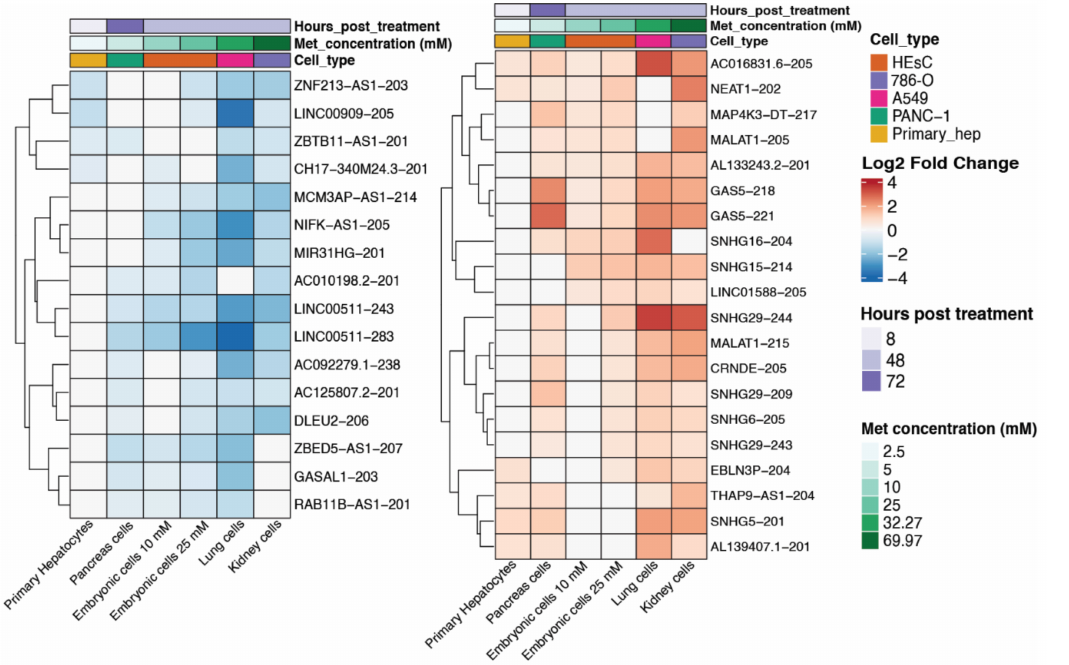
Figure 2. Heatmap of the 36 differentially expressed isoforms which are present in at least four of the six series. Heatmap was ordered according to Metformin concentration (lowest to highest, in green) and information on hours posttreatment (in purple) and cell type are present in the top. Color intensity represents log2FoldChange in the transcript in each series. Upregulated transcripts are in red, and downregulated transcripts are in blue. Panc-1: human pancreatic cell line isolated from pancreatic carcinoma. HeSC: human embryonic stem cells. 786-O: renal cell carcinoma. A549: human lung epithelial carcinoma cells. Primary hep: primary human